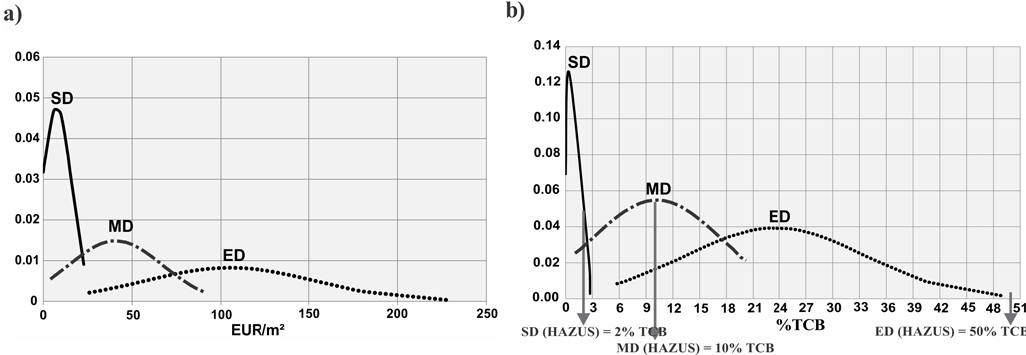
Fig. 5. (a) Normal distribution of repair cost (RC) divided by the surface of the buildings established for states of damage SD, MD and ED. (b) Normal distributions showing the percentage of the total cost of the building (TCB) represented by the RC estimated for states of damage SD, MD and ED. The highest values of the ranges proposed by Kircher et al. (1997b) for SD, MD and ED are indicated (HAZUS).